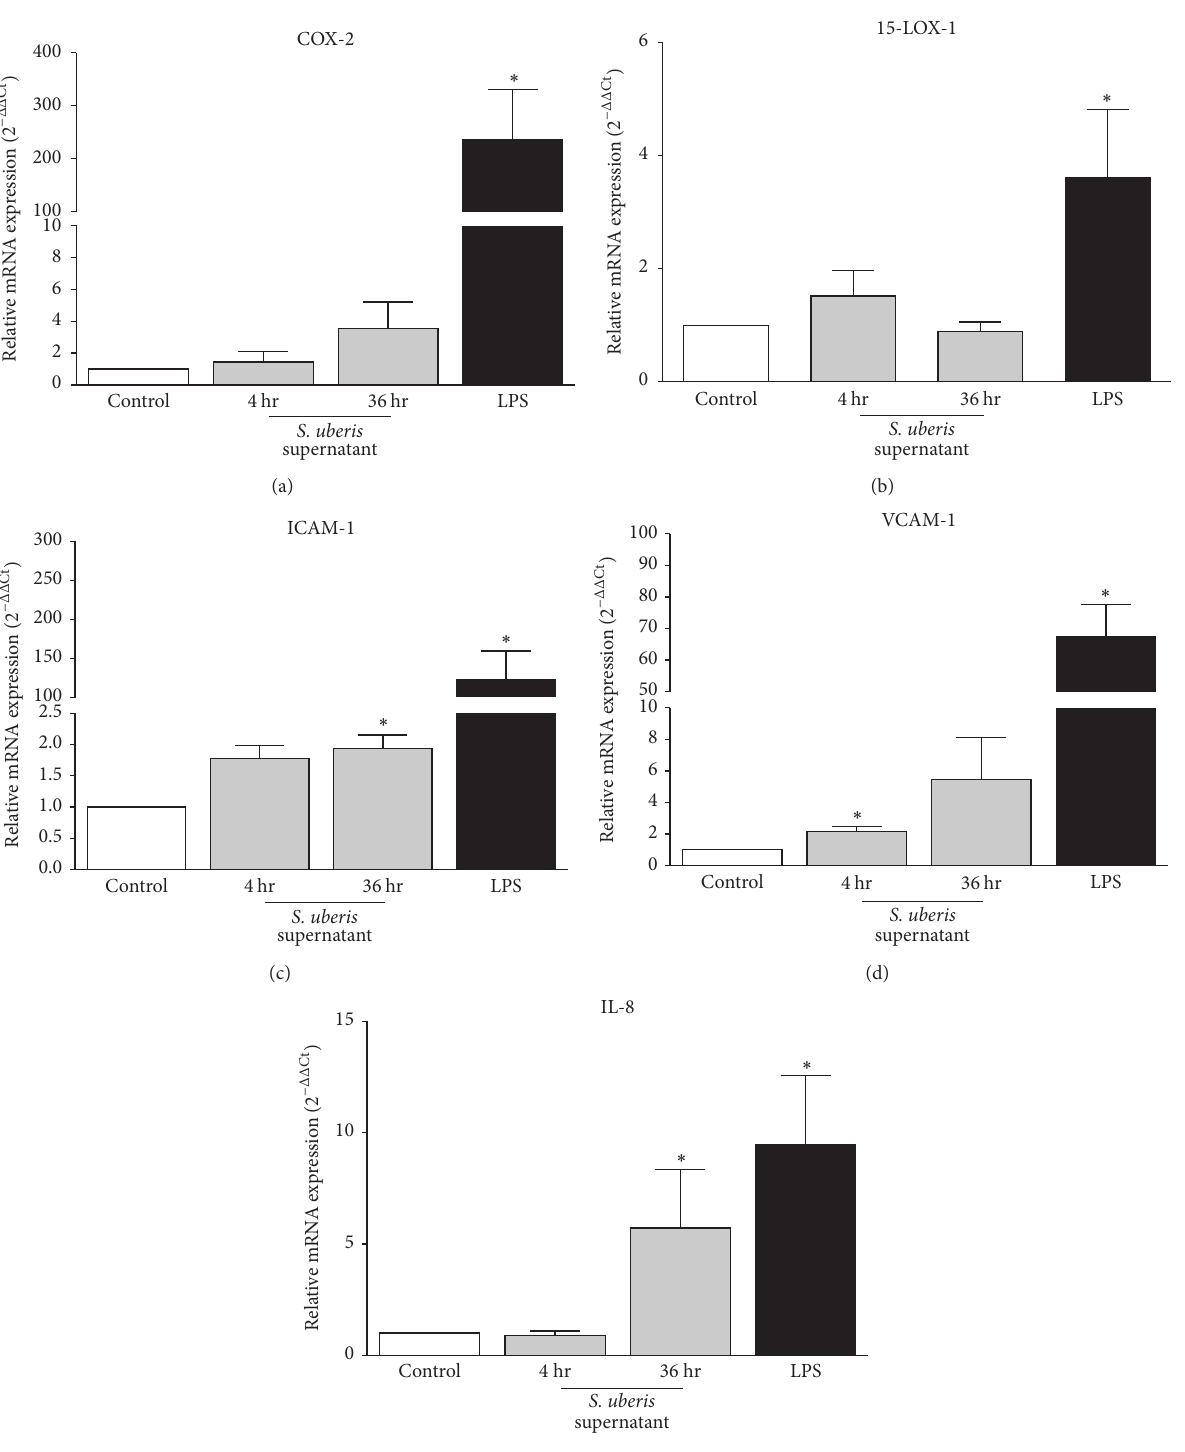
Figure 1: Mean changes in BMEC mRNA expression of oxylipid biosynthetic enzymes (a, b), adhesion molecules (c, d), and a chemotactic cytokine (e). Media controls are displayed as open bars. Positive control is 4hr lipopolysaccharide (LPS) and displayed in closed bars. Light grey bars represent S. uberis supernatant exposure for 4 hr and 36 hr. The mRNA expression is expressed as 2 −ΔΔ Ct ± SE. Asterisks ( ∗ ) denote differences between media control and treatments including S. uberis and positive control, LPS, as tested by Student’s t -tests. Significance declared for differences in Δ Ct at 𝑃 ≤ 0 .05 ( 𝑛 = 3 for all